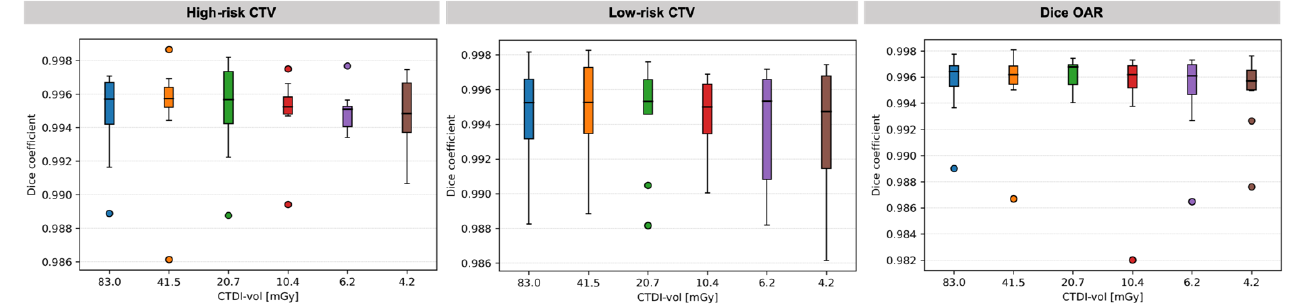
Figure 8. Similarity between contours propagated to low-dose CT and to the reference standard- protocol CT. Boxplots show: median (horizontal bar), Q1–Q3 (25th–75th) percentile (rectangle), 1.5 × (Q3–Q1) interquartile range (whiskers), outliers (dots).